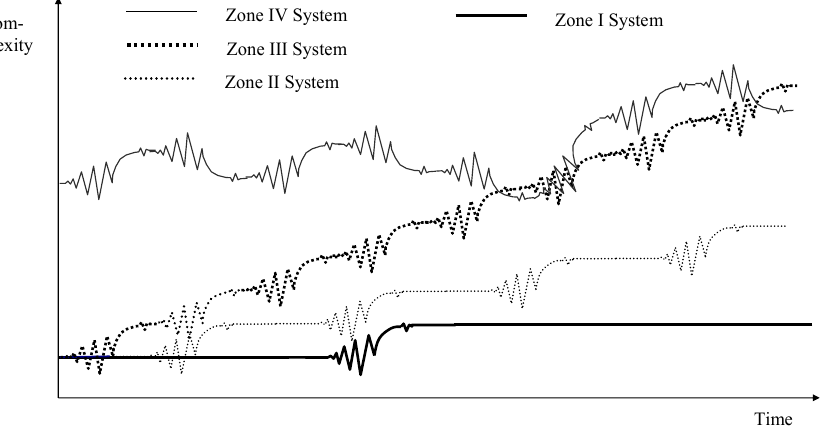
Figure 4. Dynaxity and Systems Regime. Source own, based on [9].